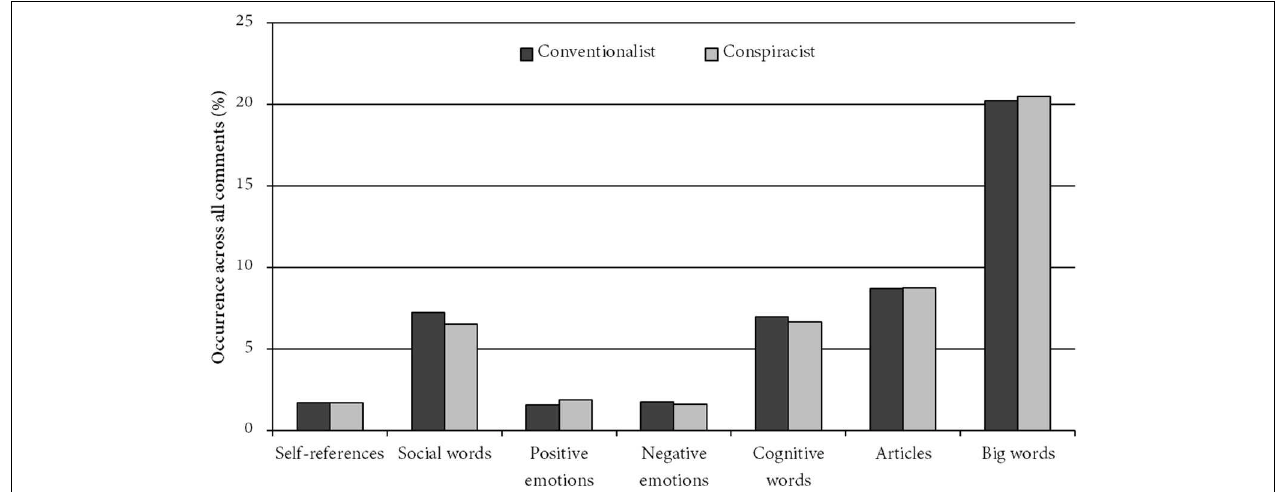
FIGURE 1 | Results from LIWC analysis of comment database, showing prevalence of self-references (I, me, my), social words, positive emotions, negative emotions, cognitive words, articles, and words with more than six